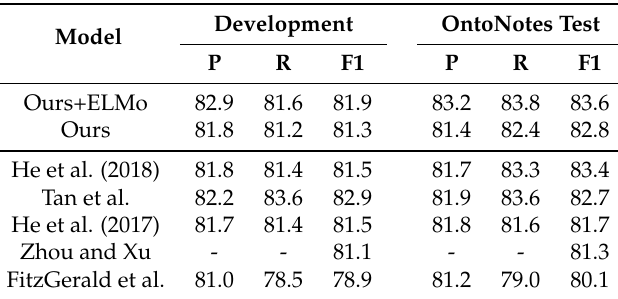
Table 2. Experimental results on the